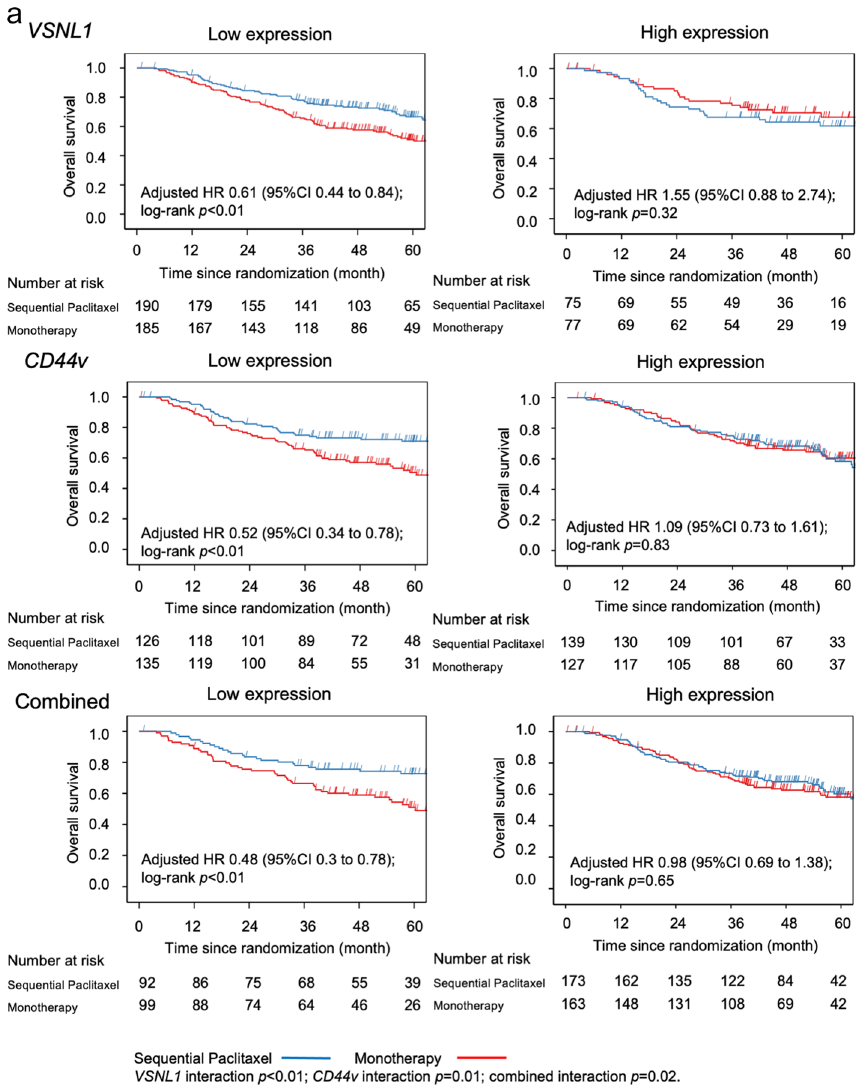
Figure 2. Kaplan–Meier curves based on gene expression level in the sequential paclitaxel and monotherapy arms. Patients with low RNA expression levels of VSNL1 , CD44 , or both had significantly longer overall survival ( a ), longer disease-free survival ( b ), and lower cumulative incidence of relapse ( c ) after sequential paclitaxel treatment than after